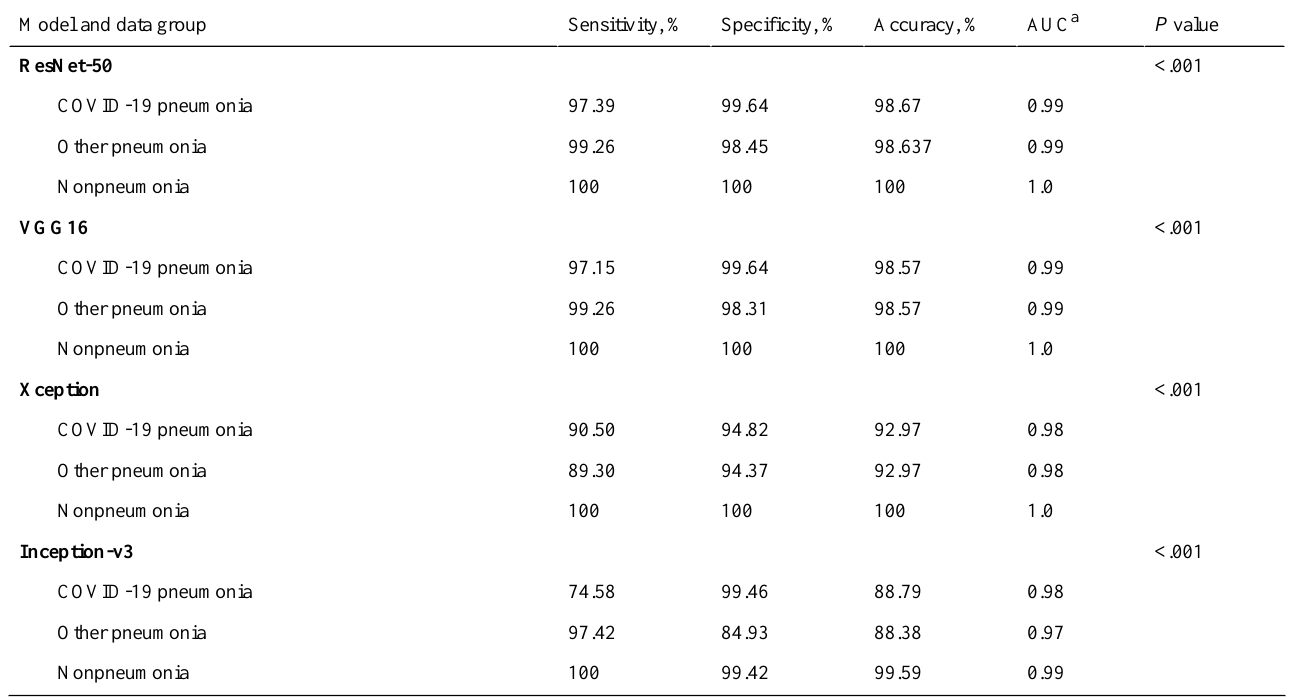
Table 6. Performance of the FCONet framework based on institutional data split for COVID-19